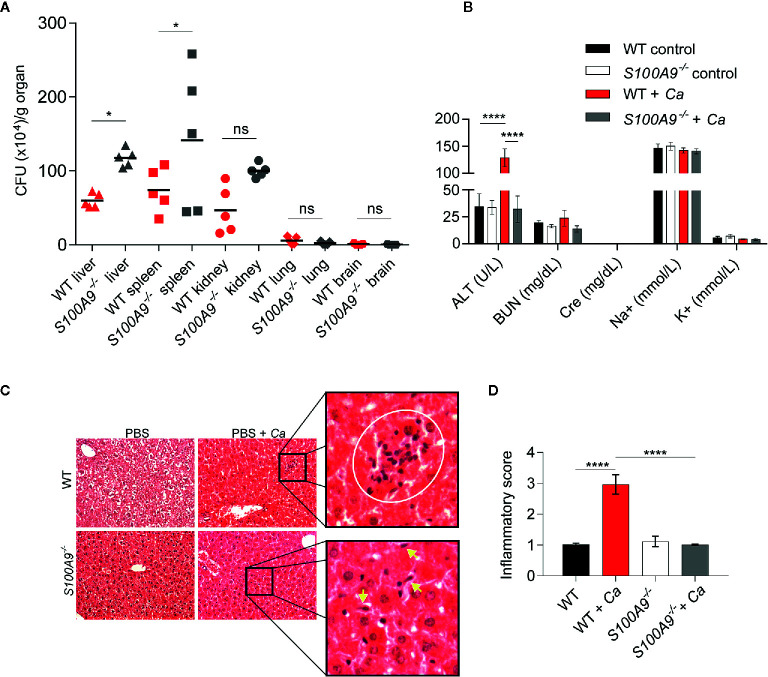
Disseminated C. albicans peritonitis mouse model depicts the importance of S100A8/A9 in fungal dissemination and ICTD in the liver. Intraperitoneal C. albicans infection (3 × 106 cells per g mouse) in WT or S100A8/A9-deficient (S100A9
-/-) mice is shown after 24 h. As described in the text, the knockout mouse strain completely lacks protein expression of both subunits of the S100A8/A9 complex. (A)
C. albicans dissemination into liver, spleen, kidney, lung and brain was determined by CFUs per g organ. Fungal burden is higher in liver and spleen from S100A9
-/- than from WT mice. Data is from one of two experiments using n = 5 mice per group and shown as means. Statistical significance was evaluated using a one-way ANOVA with Sidak’s multiple comparison test (B) To determine organ damage, plasma was harvested from infected animals and uninfected controls. Plasma (100 µl) was analyzed using a Vetscan VS2 clinical chemistry system. Shown are values for alanine aminotransferase (ALT), blood nitrogen urea (BUN), creatinine (Cre), sodium (Na+), and potassium (K+). Only ALT, indicative of liver damage, was significantly increased in infected WT and but not in S100A9
-/- mice. Data are from one of four experiments using n = 6 mice for infected and n = 3 mice for uninfected mice and presented as means while error bars depict standard deviation (SD). Statistical significance was evaluated using a two-way ANOVA with Tukey’s multiple comparison test. (C) Analysis of histological liver tissue sections from infected animals revealed that lack of S100A8/A9 led to reduced inflammation and leukocyte infiltration zones in the organ. Shown are representative photomicrographs of hematoxylin-eosin (H&E) stained liver sections of uninfected and infected WT and S100A9
-/- mice. Zoomed images show increased inflammatory leukocyte infiltrates (white circle) in WT-infected cells (top panel). Yellow arrows indicate fungal cells (bottom panel) at 20× magnification. CV: central vein, PV: portal vein. (D) Quantification of (C). An inflammatory score of H & E-stained liver sections of uninfected and infected WT and S100A9-/- mice. A score of 2 = moderate cell infiltration, >3 = large number of infiltrates, 4 = full tissue inflammatory infiltration. Data is from 10× microscopy image fields of two sections from mice n = 2 (WT and S100A9
-/-) and n = 6 (WT + Ca and S100A9
-/-
+ Ca) from two independent experiments. Error bars indicate SD as evaluated using a one-way ANOVA with Tukey’s multiple comparison test, statistical significance with *equals p-value < 0.05, ****p-value < 0.0001, and ns, not significant.